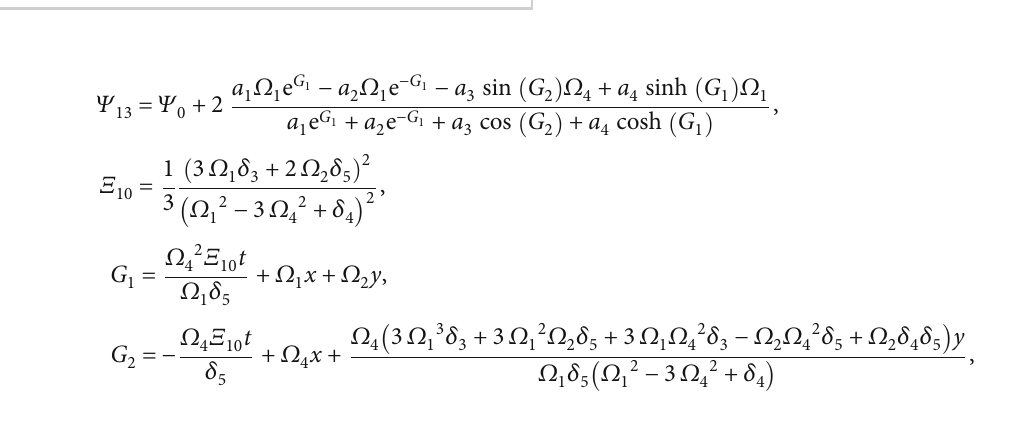
= 2, Ψ = 1, t = 10 and (a) 3D plot, (b) density plot, and (c) contour 5 0